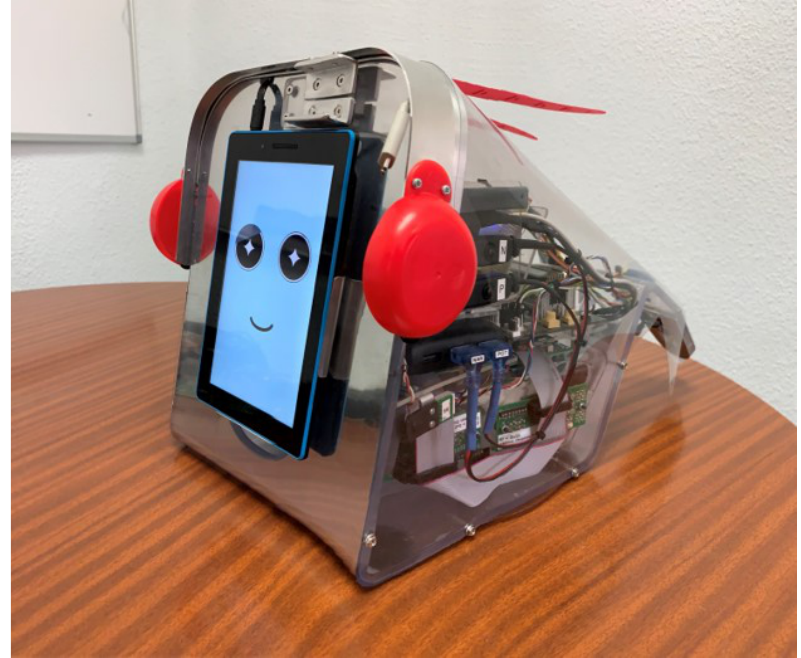
Figure 2. UPM-CSIC CAR personal assistance